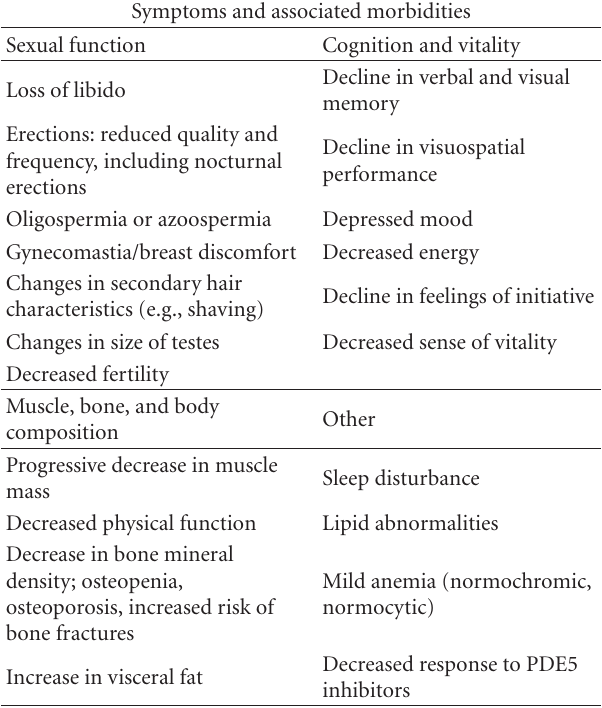
Table 2: Symptoms and associated morbidities with low testos- terone